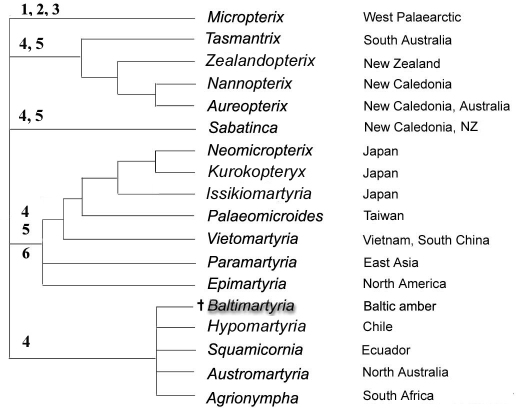
Presumed phylogenetic relationships within Micropterigidae based on Gibbs (2010).